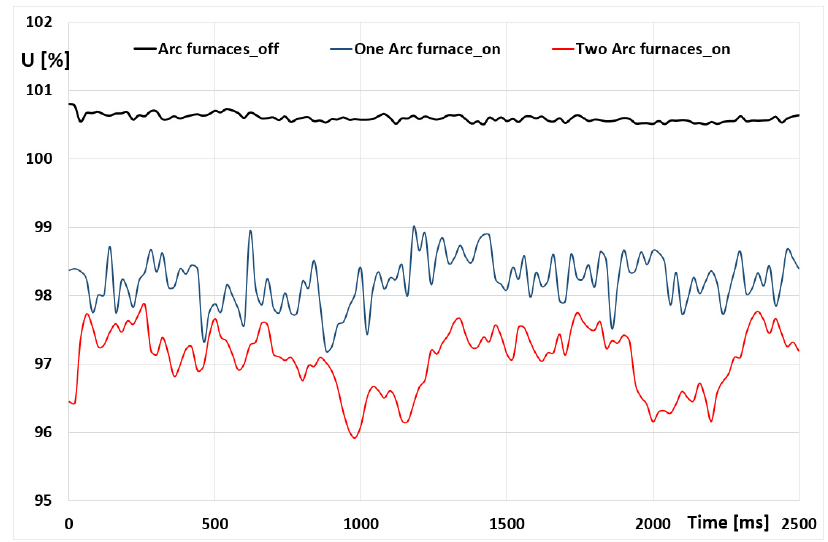
Figure 13. RMS value changes recorded in the steel network supplying the steelworks with different numbers of arc furnaces.